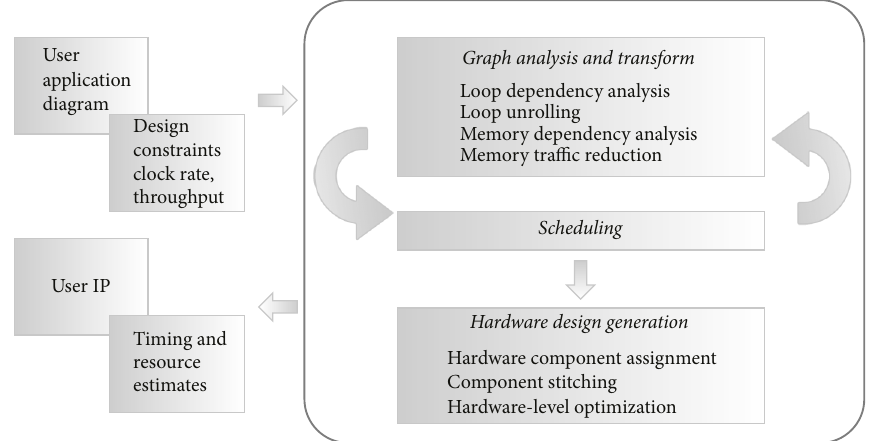
Figure 2: Illustration of the HLS compile